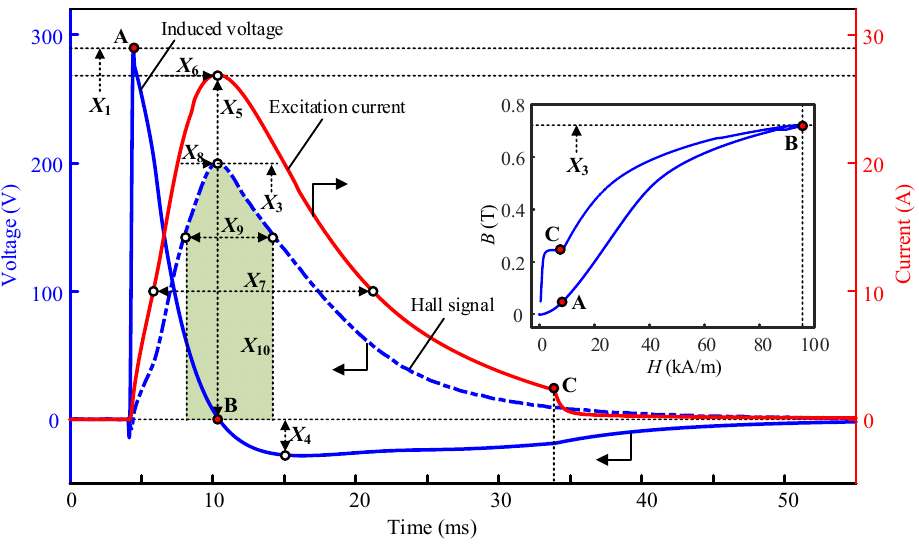
Figure 3. The symbols and physical meaning of the candidate parameters are listed in Table 2.